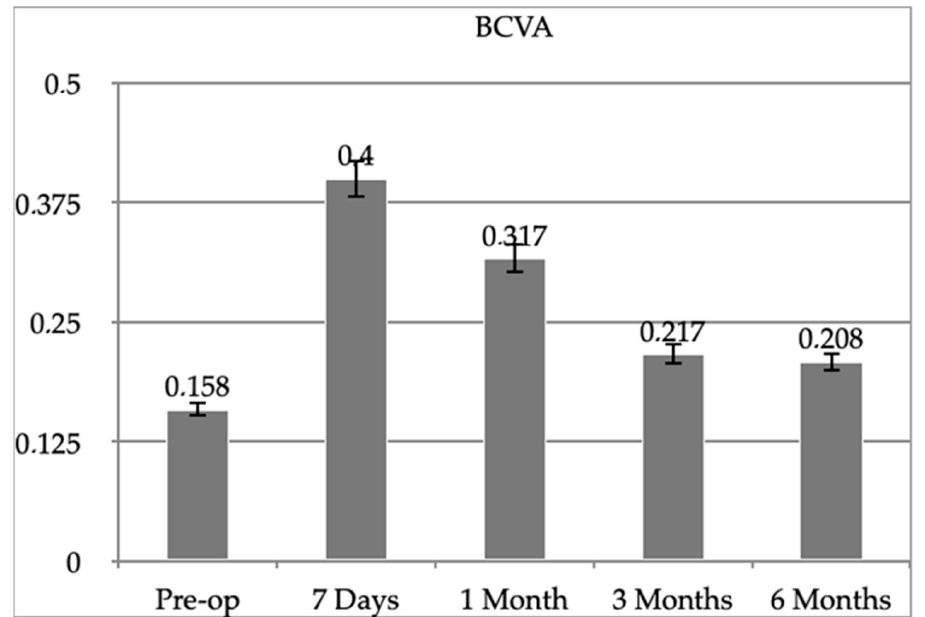
Figure 3. BCVA results.